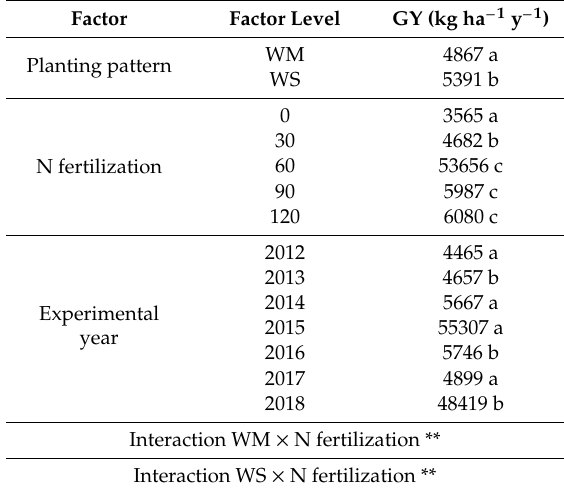
Table 2. Grain yield, as a ff ected by planting pattern, nitrogen fertilization and the experimental year. Statistical di ff erences among grain yields within planting pattern, N-fertilization doses and experimental year.